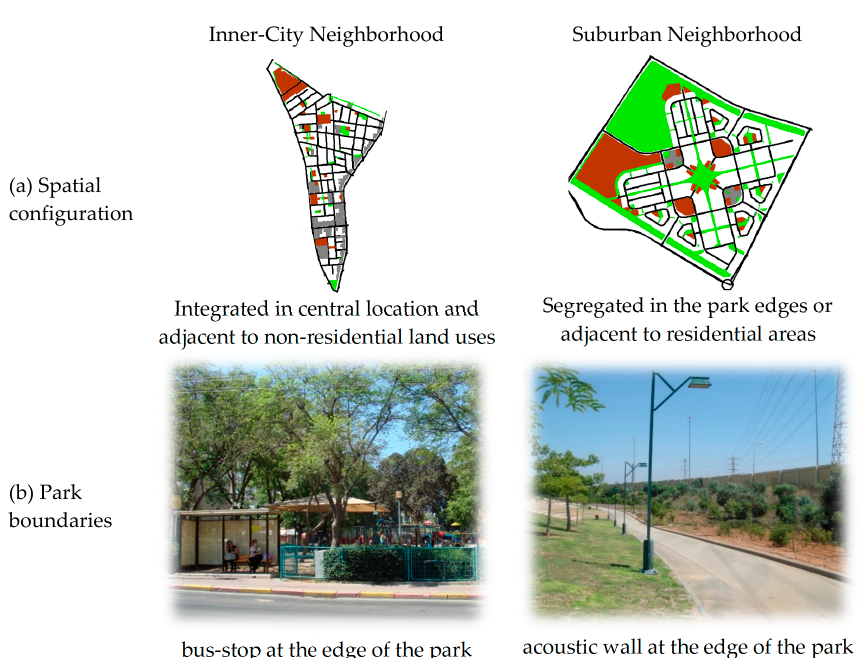
Figure 2. Spatial configuration and internal characteristics of parks in suburban and inner-city parks.